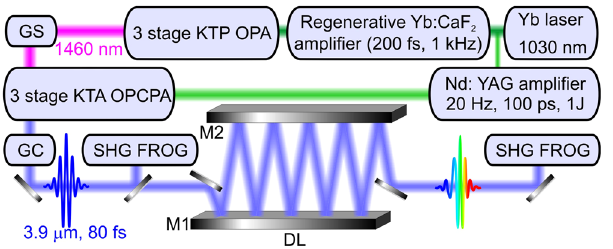
Figure 2. Experimental setup: GS, grism stretcher; GC, grating compressor; DL, 60-m propagation-path delay line; M1, M2,